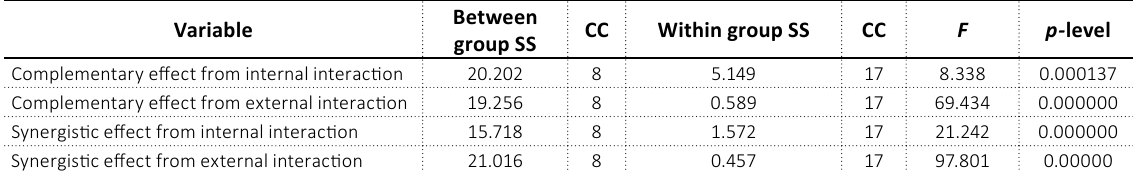
Table 5. Variance analysis results from brand clustering within Fozzy Group business